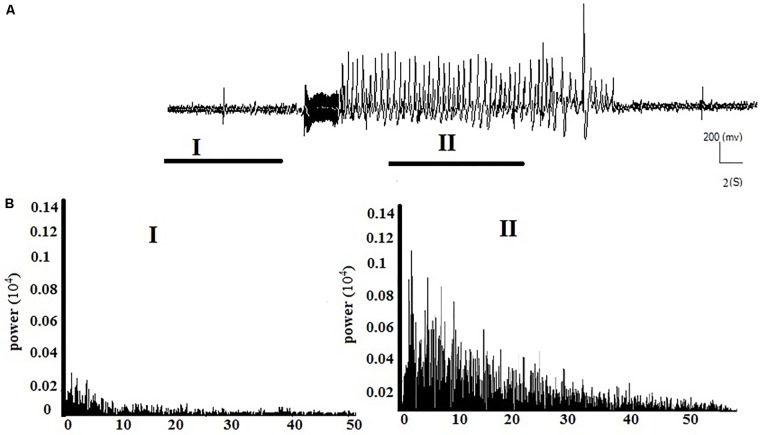
Example of the EEG record and corresponding FFT analysis in the kindle group. (A) A continuous baseline EEG record from the baseline period (I) to the AD duration (II). (B) The power spectrum corresponding to each phase of the EEG using FFT analysis.